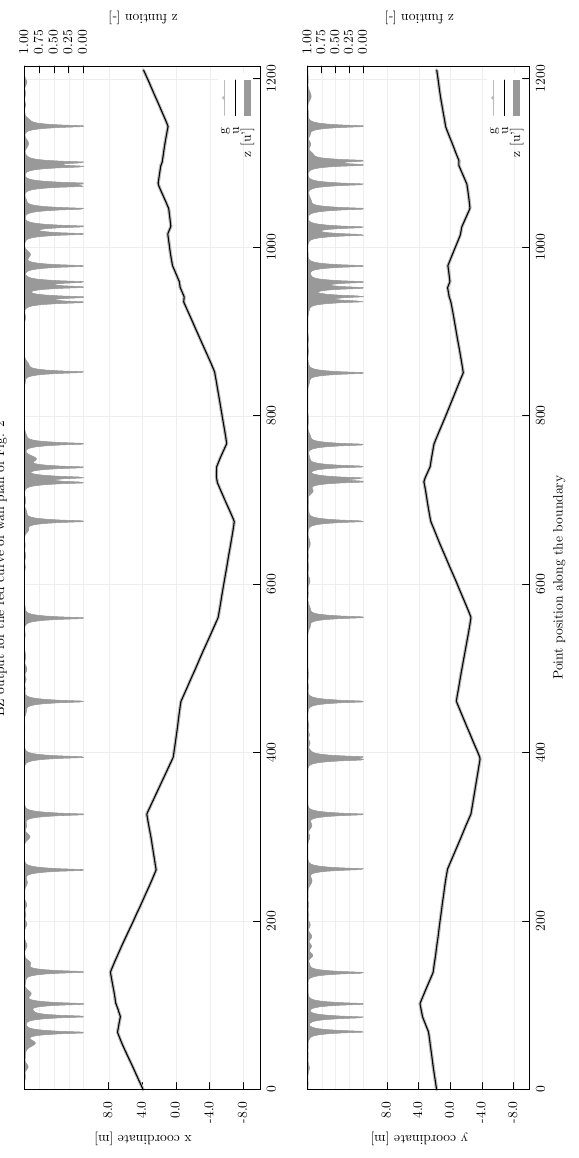
Figure 3: Plot of the auxiliary function z produced by the Blake- Zisserman model applied to the red element of the wall plan of Figure (2)